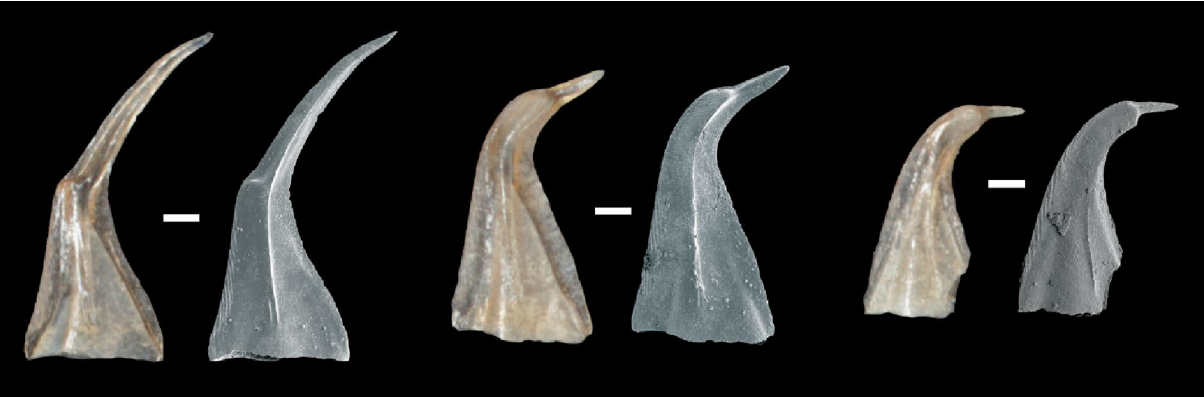
Figure 3. Reflected light photomicrograph and SEM images of broken and regrown S b–c elements of D. obliquicostatus from the same stratigraphic interval as sampled in this study. All scale bars at 100 μm and all images are scaled to the same size. The breaks are almost always at the point of maximum curvature and do not appear to be preferentially related to the extent of white